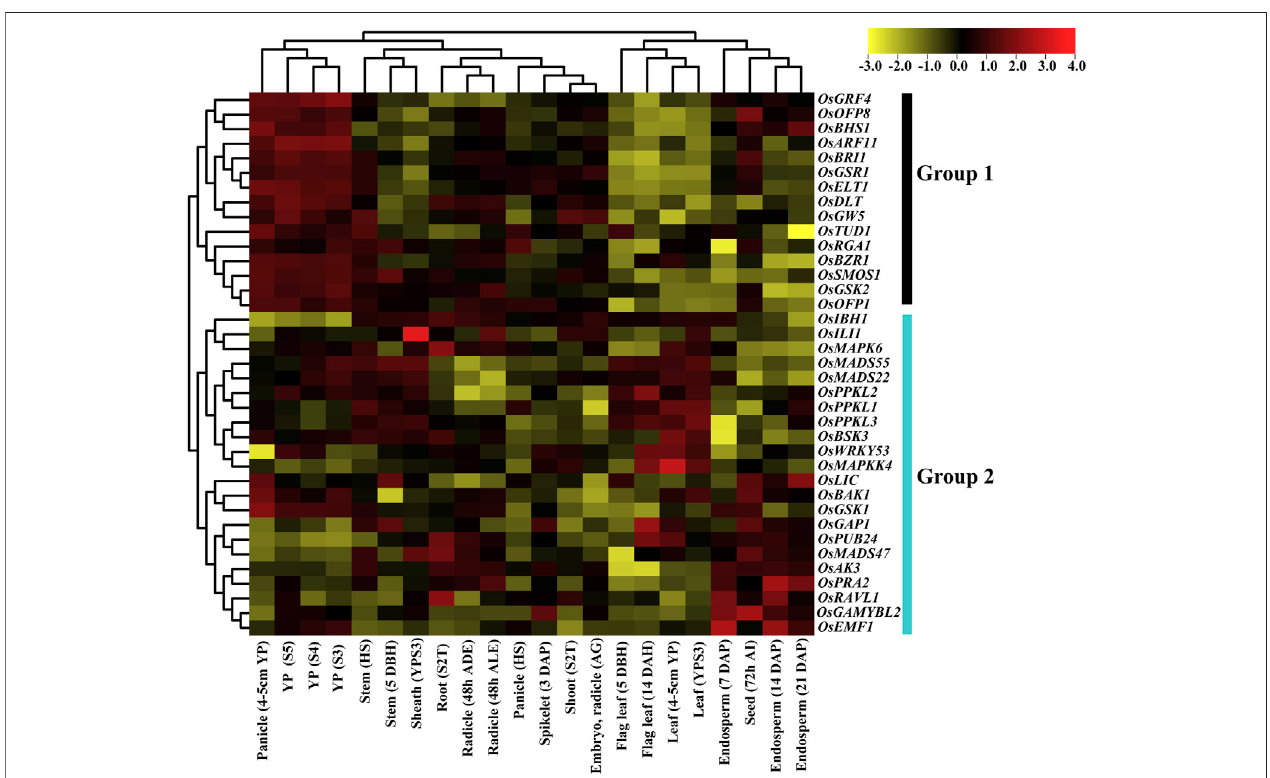
FIGURE 7 | Expression pattern of the BR signaling genes in rice. Abbreviations: YP: Young panicle; HS: Heading stage; DBH: Days before heading; YPS3: Young panicle at stage 3; S2T: Stage with 2 tillers; ADE After dark emergence; ALE: after light emergence; DAP: Days after pollination; DBH: Days before heading; DAH: Days after heading; AI: after